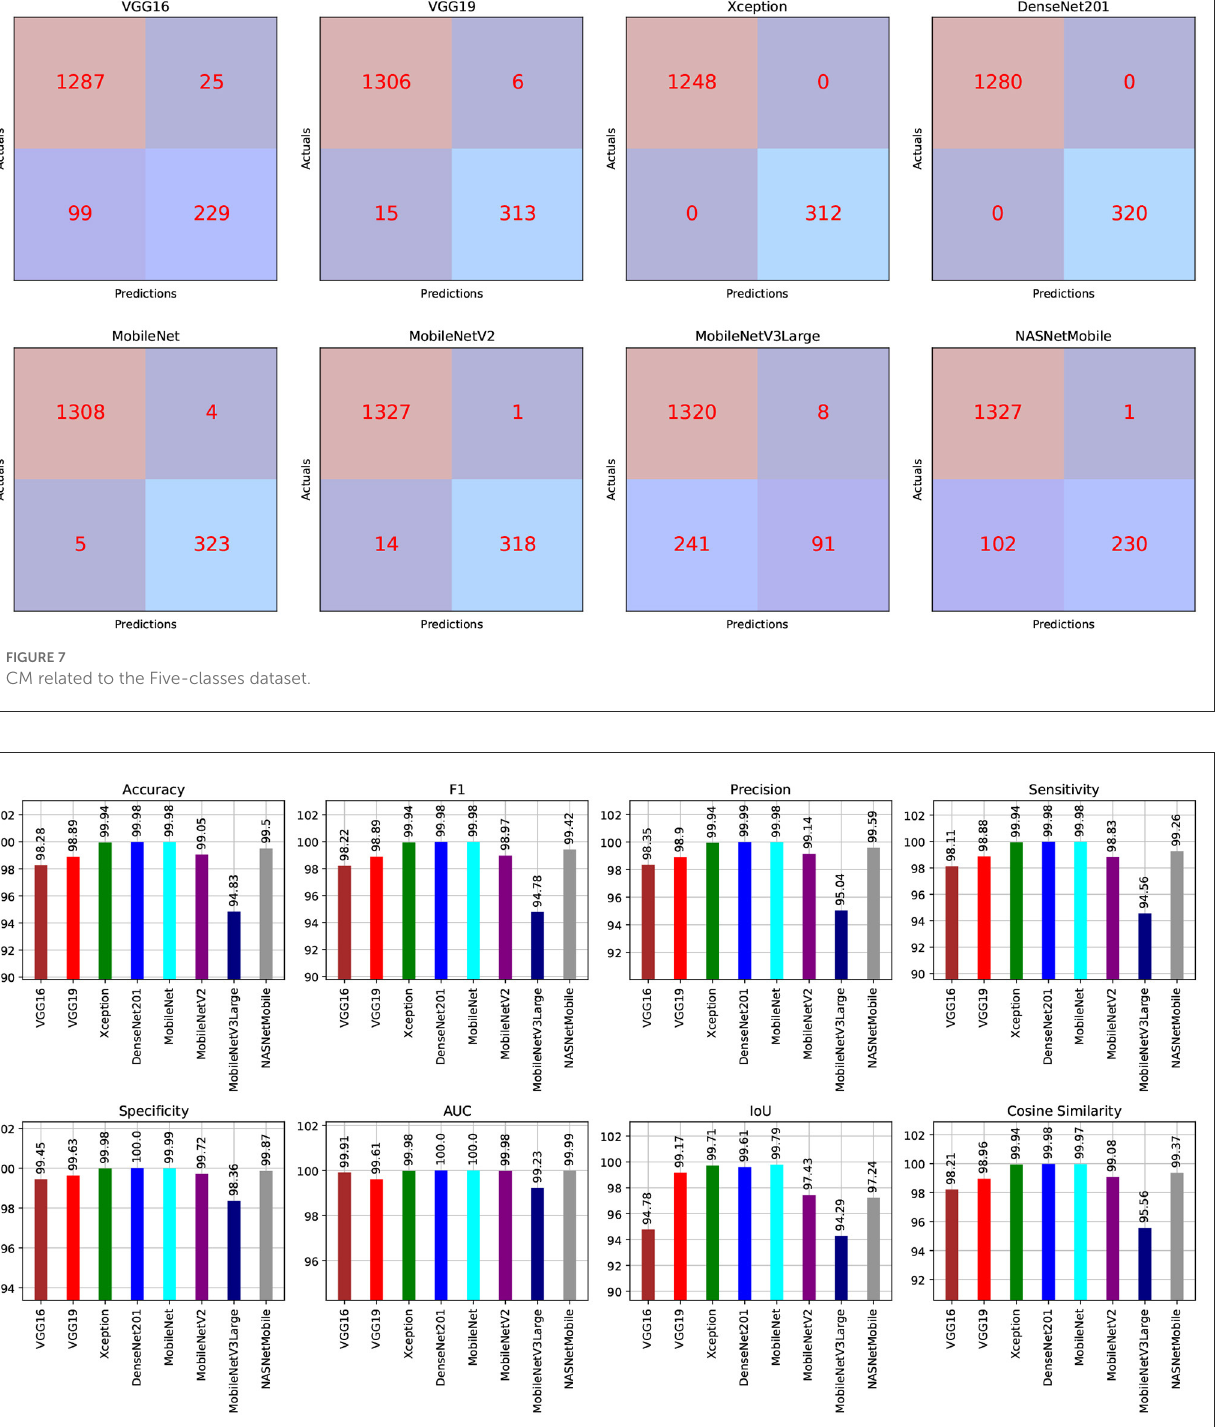
The TP, TN, FP, and FN of the best solutions for each pre- trained model after learning and optimization operations for the Four-classes dataset are reported in Table 13. The pre-trained DenseNet201 model, for example, has the lowest FP and FN